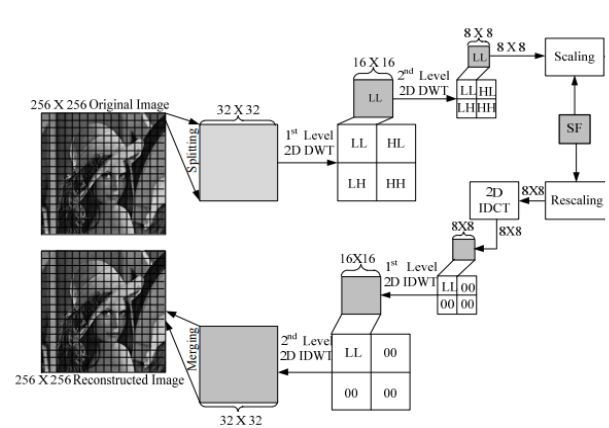
Figure 6. Block diagram of DWT